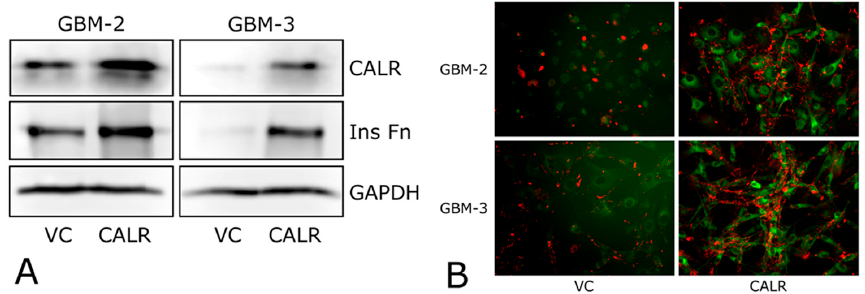
Figure 5. Transfection of GBM cells with a CALR expression vector induces FNMA. Immunoblot ( A ) and immunofluorescence ( B ) analysis of GBM-2 and GBM-3 cells transfected with a CALR expression plasmid or an empty vector control (VC). Increased levels of CALR correspond to an increase in the production of an insoluble fibronectin matrix (InsFn, A) and in long fibronectin fibrils ( B ). Red signal (assembled fibronectin matrix), green signal (CALR-GFP fusion protein).